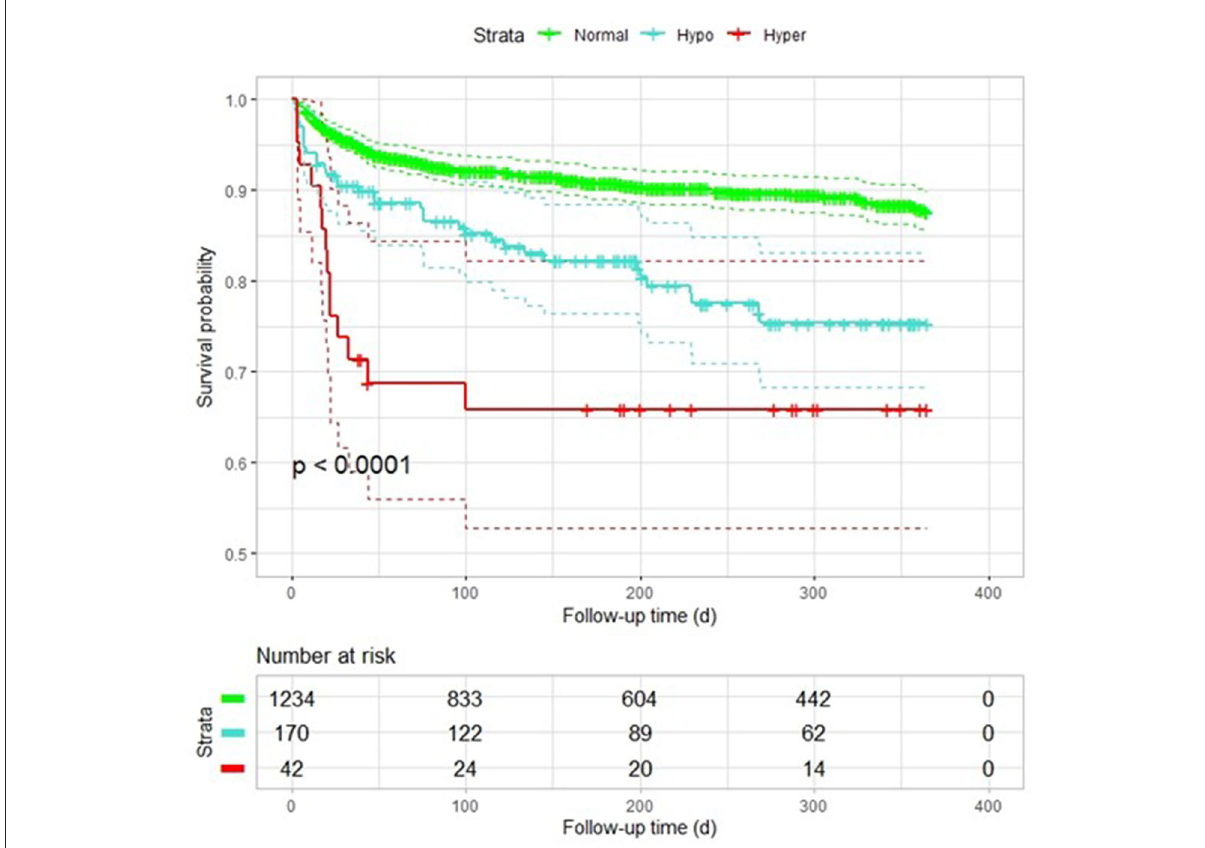
FIGURE2 Kaplan–Meier plot of survival probability among patients with AF with different sodium levels. Hypo, hyponatremia; Normal, normonatremia; Hyper, hypernatremia.